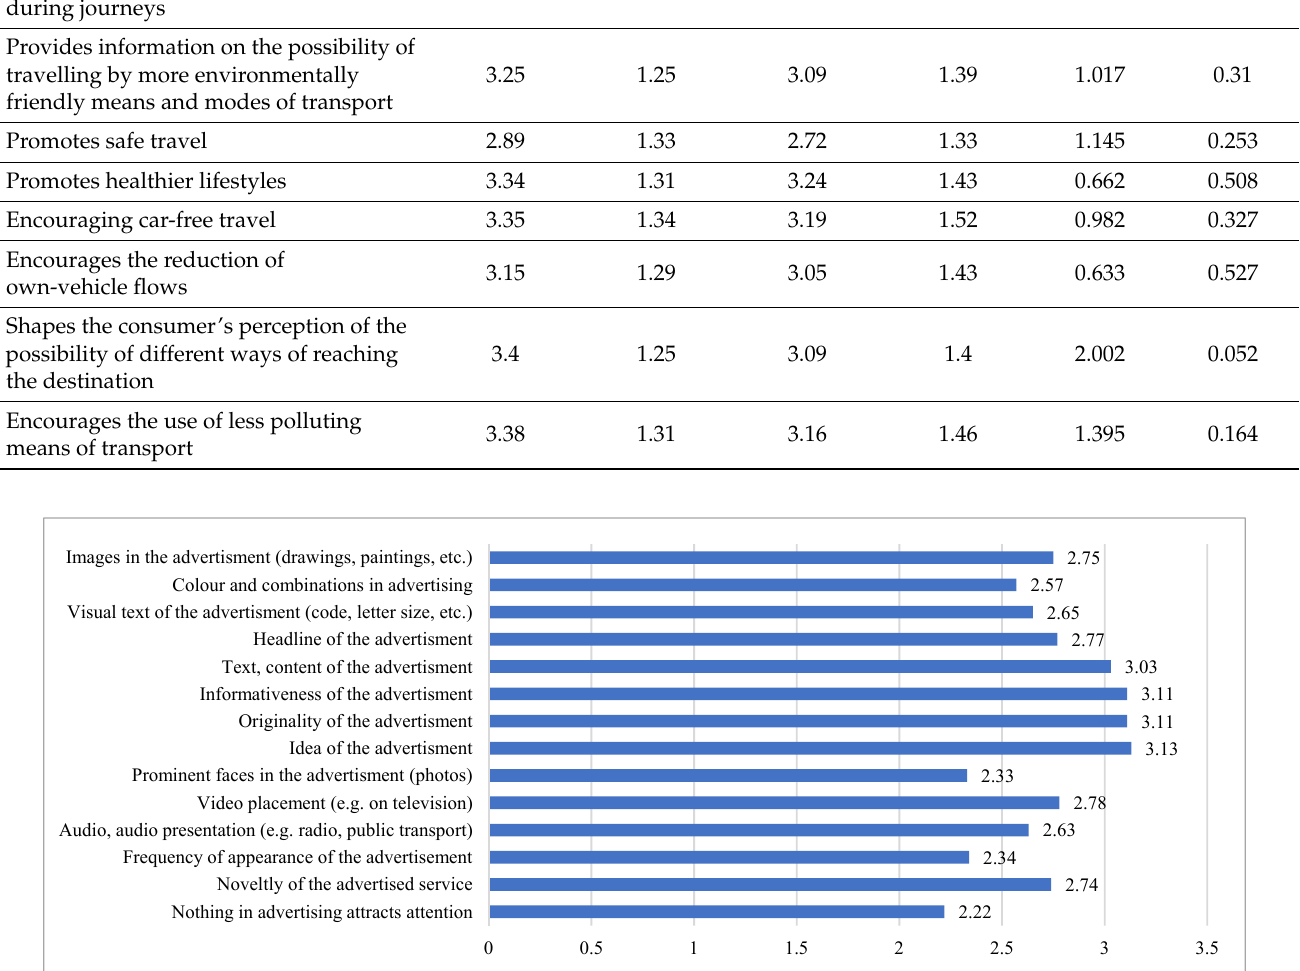
Figure 5. Evaluation of advertising elements influencing the decision to travel based on sustainable mobility and multimodality ( n = 396; mean values ( M ), max = 5). A comparative analysis (see Table 4) of the data for the different age groups showed that for participants under 45 years of age, the visual text, font, letter size, etc. of the ad- vertisement was not the most important element of the advertisement ( M = 2.89), the col- ours and combinations of colours ( M = 2.84), as well as the originality of the advertisement ( M = 3.34) and the frequency with which the advertisement is shown ( M = 2.54), have a greater influence on the decision to travel on the basis of the principles of sustainable mo- bility and multimodality than for older respondents (aged 46 and over), for which statis- tically significant lower mean values were found (respectively: ( M = 2.53), ( M = 2.43), ( M = 3.01) and ( M = 2.24)). Table 4. Evaluation of advertising elements influencing the decision to travel on the basis of sus- tainable mobility and multimodality for different age groups ( t -test for independent samples). Up to 45 Years of Age Group